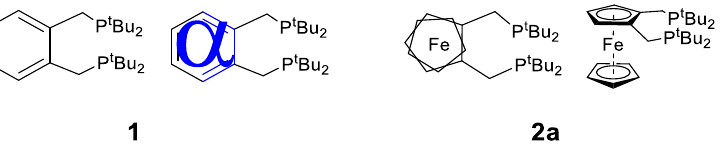
Figure 5. The Alpha ligand, 1,2-bis (di- tert -butylphosphinomethyl)benzene ( 1 ), with a top view of butphos ( 2a ), its ferrocene-based equivalent.